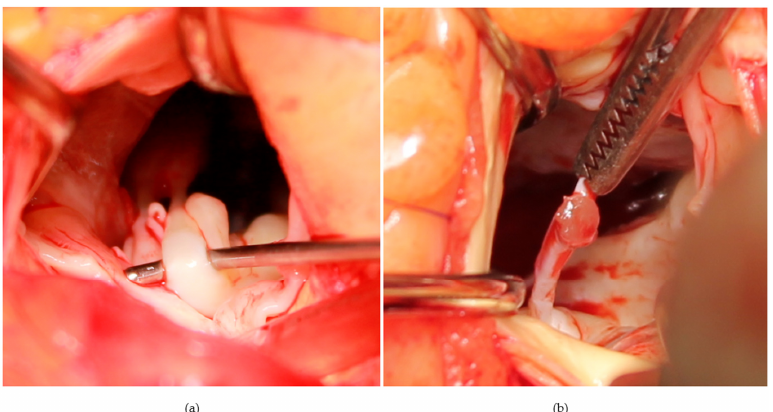
Figure 2. ( a ) Thick secondary chord of the anterior mitral leaflet; ( b ) secondary chord cut at its papillary muscle insertion; it is still attached to the anterior mitral leaflet.